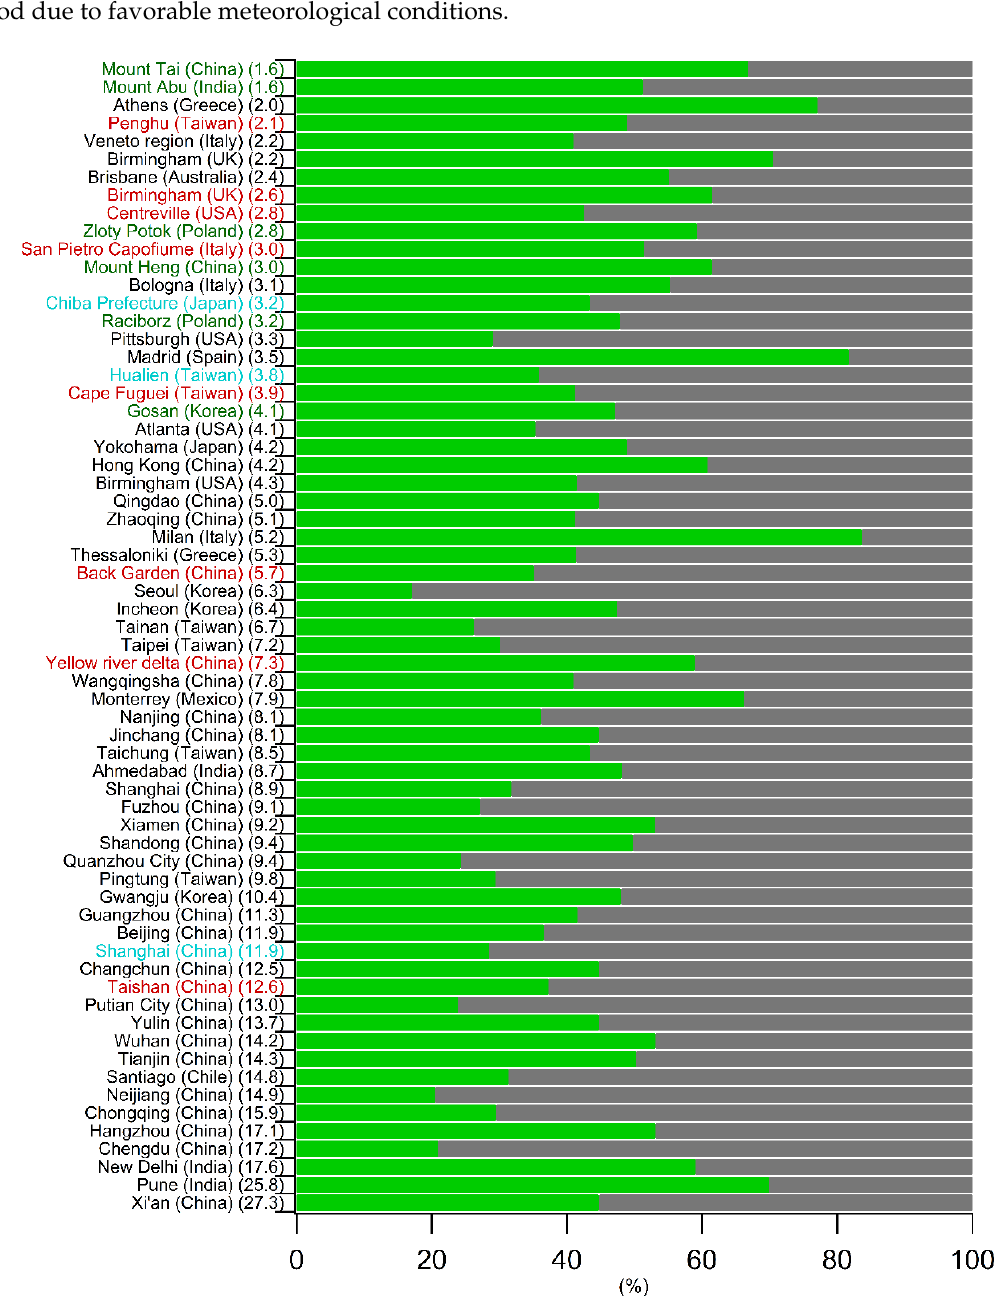
Figure 3. Spring–summer SOC (green) and POC (grey) contributions to PM 2.5 OC estimated using the EC tracer method for all the monitored sites from 2006 to 2016. Results are presented in increasing order of OC concentration levels ( µ gC m − 3 ). In black, urban sites; in blue, suburban sites; in red, rural sites and in green, remote sites.